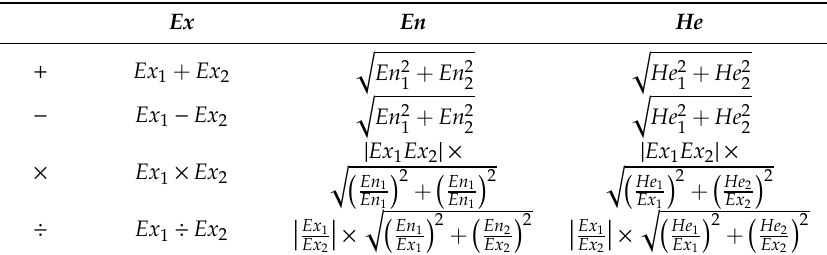
Table 2. Reliability rule of the air traffic network.